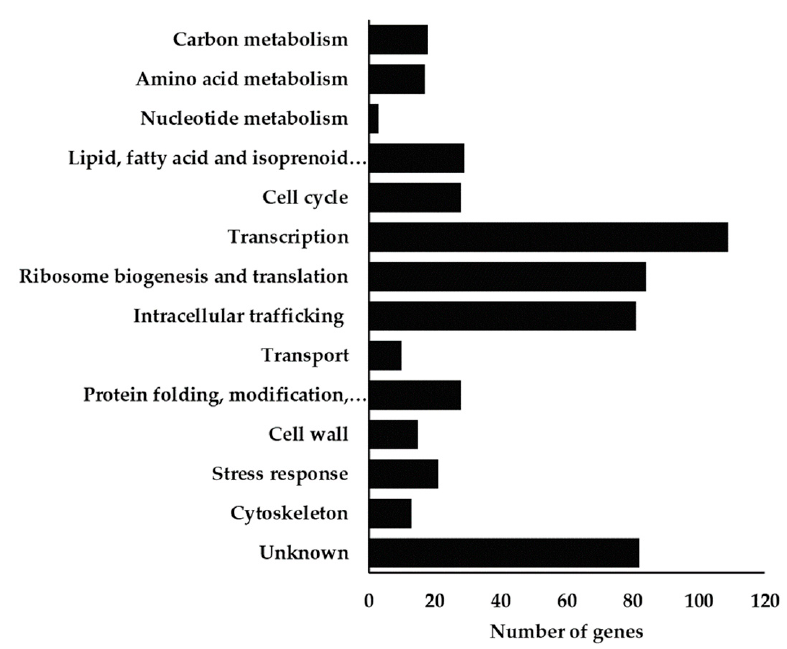
Figure 4. Functional categorization of genes whose deletion led to increased sensitivity to chitosan No Brett Inside ® . Assignment of genes to their functional categories was performed using information from MIPS and SGD databases, further subjected to some manual curation.